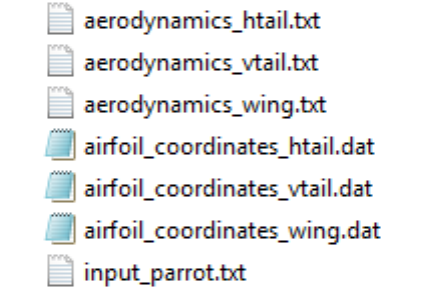
Figure 4: Text files with Input data. Table 1: Air Cargo Challenge 2015 regulations